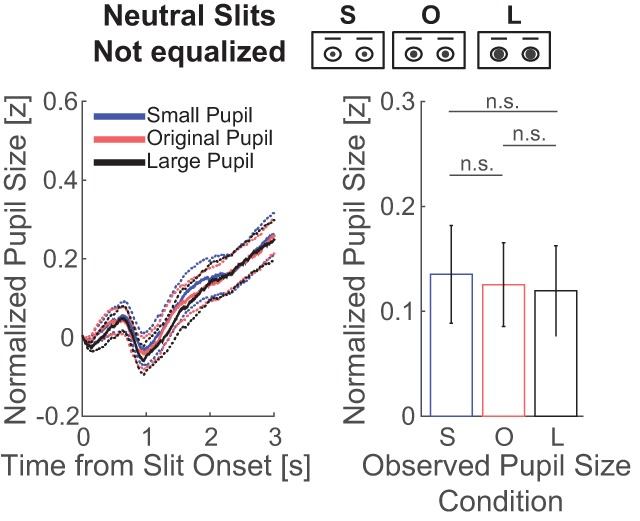
The left plot shows the average change in pupil size across observers as a function of time from slit onset (solid lines) per observed pupil-size condition (small pupil: blue; original pupil: red; large pupil: black) in experiment 1. The displayed eye regions in the slits were not equalized in luminance and contrast. The dotted lines around the solid lines indicate standard errors of the mean. The right plot shows the average and standard error of the change in pupil size across observers, after averaging between 1 and 3 seconds from slit onset, per observed pupil-size condition (small: S; original: O; large: L; n.s.: not significant).